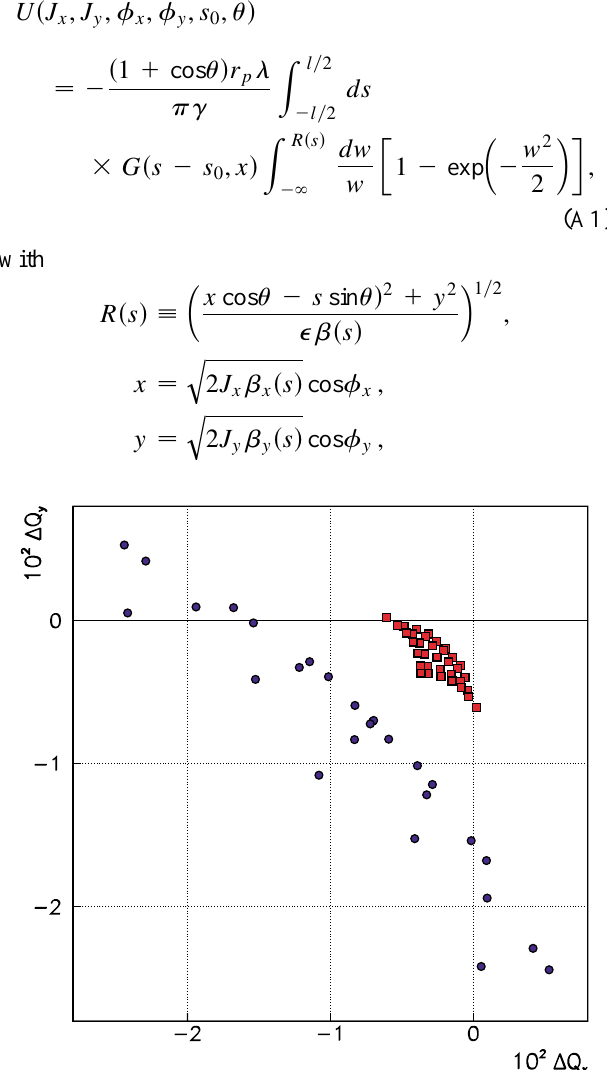
FIG. 4. (Color) Tune footprints for superbunches colliding un- der two different crossing angles: u (cid:1) 400 m rad (blue circles) and u (cid:1) 1 mrad (red squares), and betatron amplitudes ex- tending from 0 to 6 s . Other parameters: line density l (cid:1) 8.8 3 10 11 m 2 1 , IP beta functions b (cid:1) (cid:4) b (cid:1) interaction length per IP l (cid:1) 40